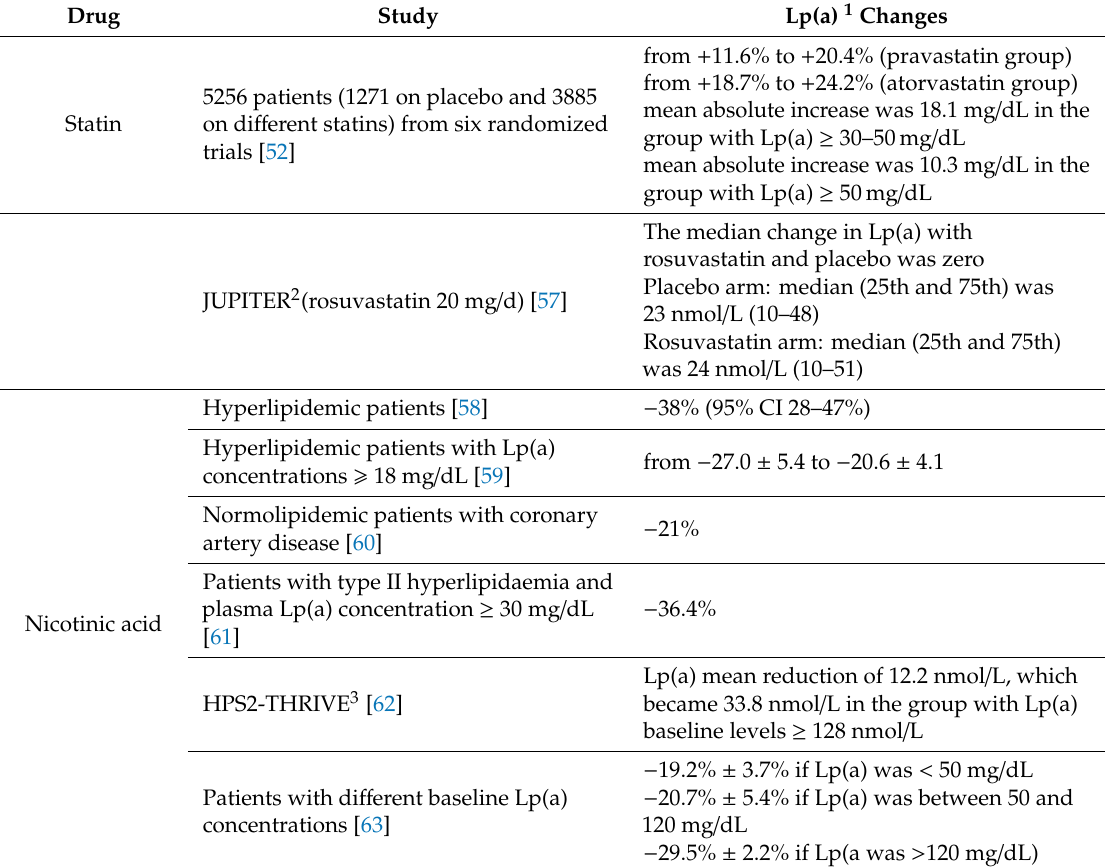
baseline levels ≥ 128 nmol / L